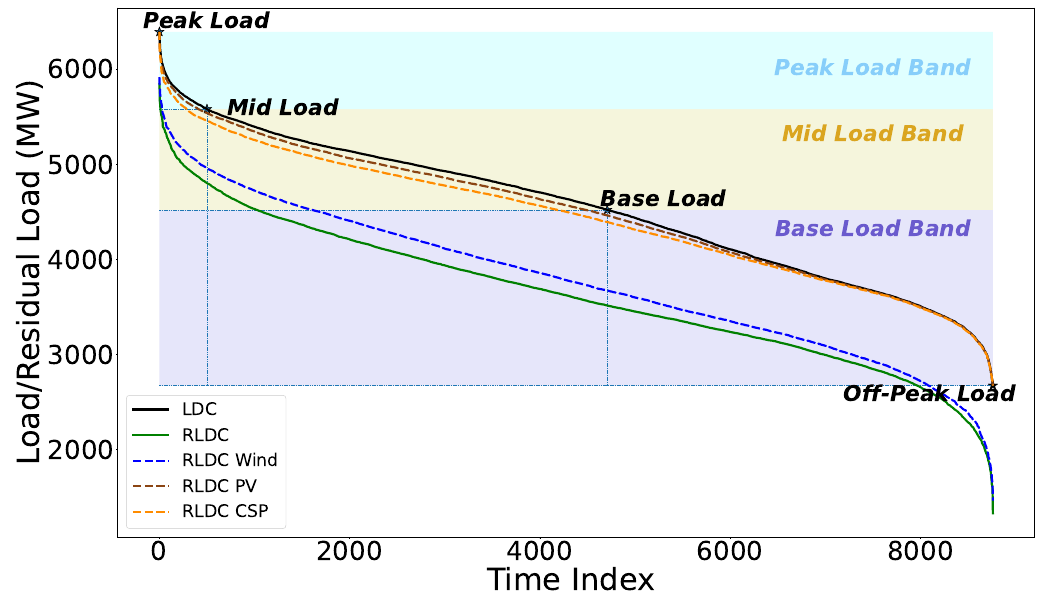
Figure 2. LDC (plain black), RLDC (plain green), RLDC for PV only (dashed brown), RLDC for CSP only (dashed orange), and RLDC for wind only (dashed blue) for the optimal PV-Wind-CSP-SM1.5 mix for the global strategy with the maximum-cost constraint and at a mean penetration of 20%. See Section 3 for more